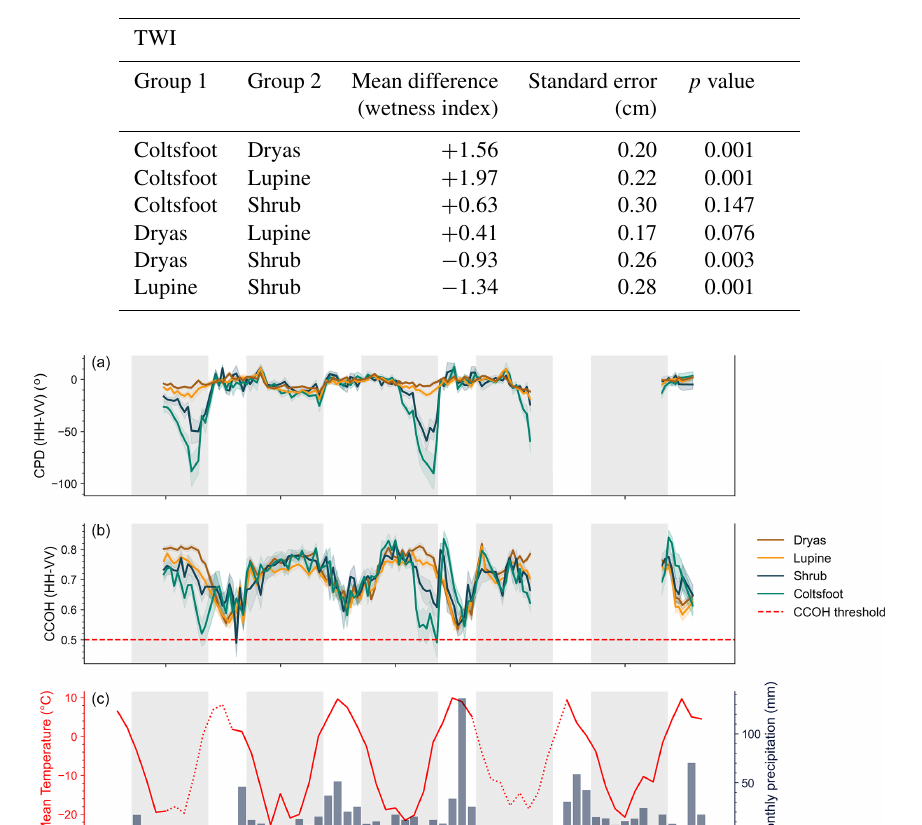
Table 5. Post hoc analysis with Games–Howell for the TWI (non-parametric test). Each row presents the variance between TWI means from two different groups. All vegetation groups were tested on each other.